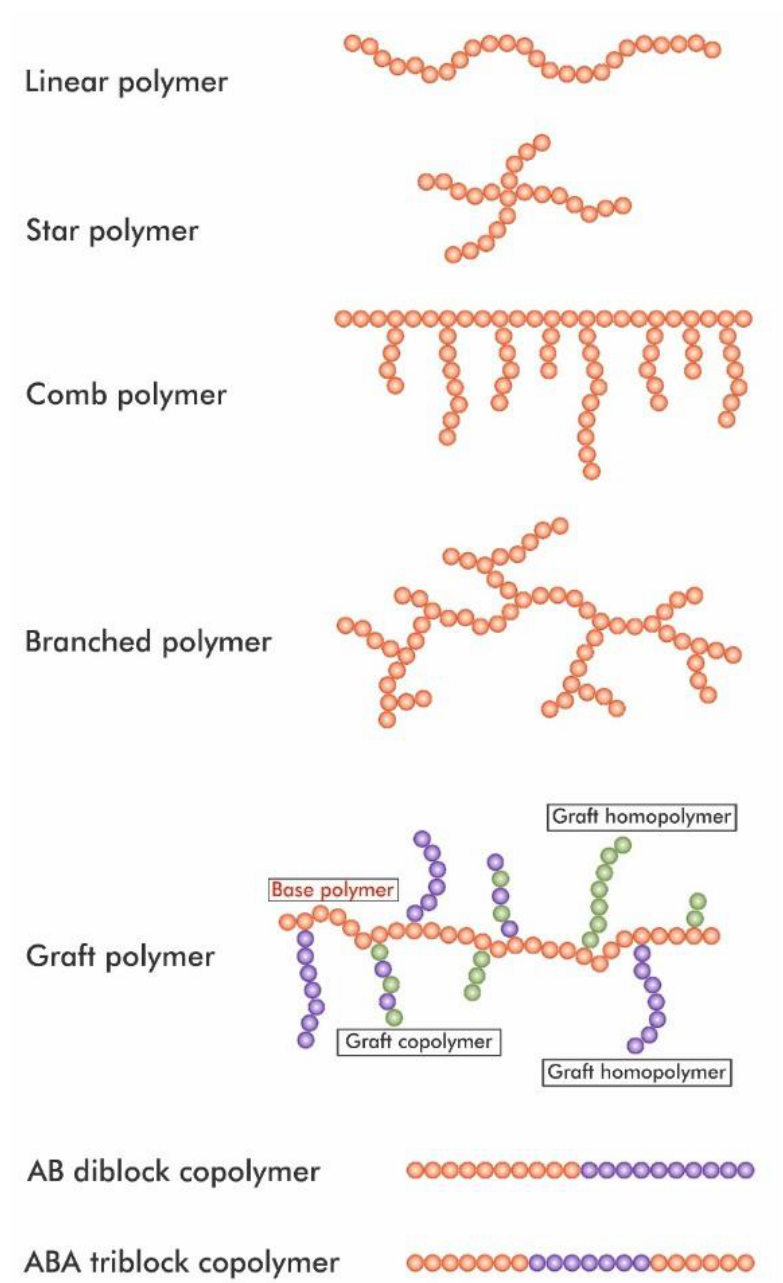
Figure 14. Summary of the selected polymer and copolymer architectures [50–52].